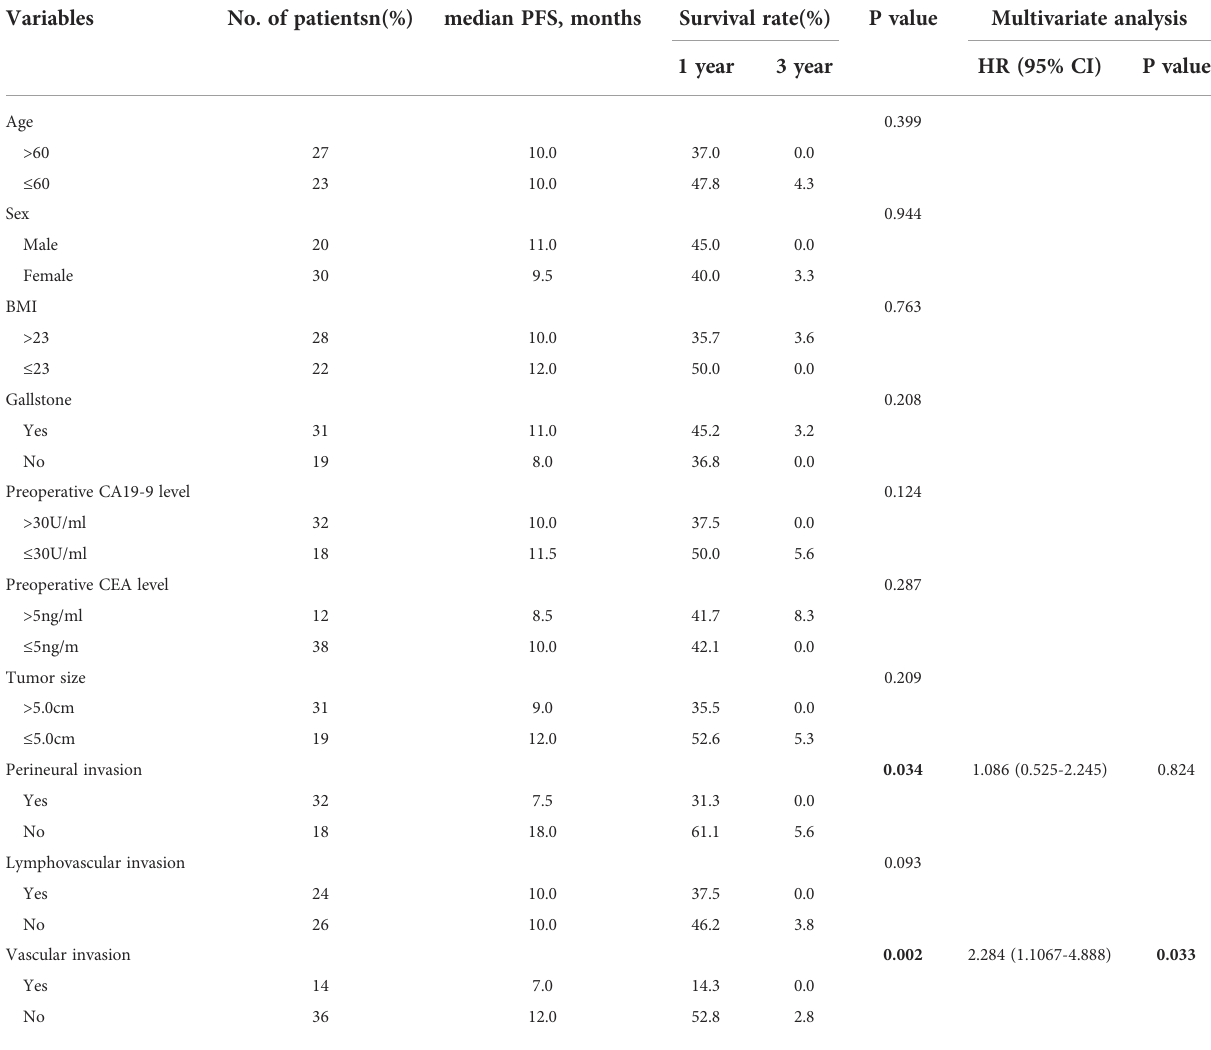
TABLE 2 Univariate and multivariate analysis of PFS for patients with